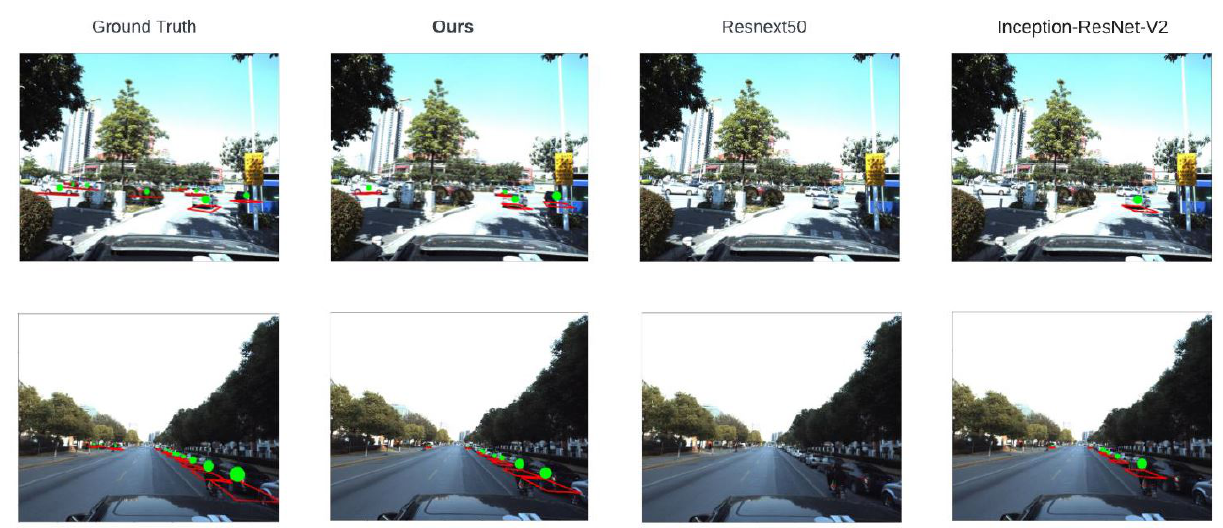
Figure 12. Results visualization in comparison with existing methods and ground